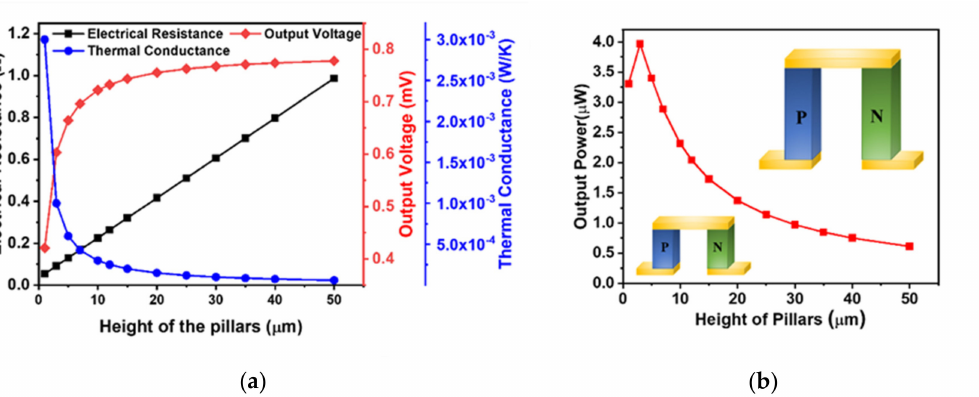
Figure 4. ( a ) Electrical resistance, output voltage and thermal conductance vs. pillars’ height at 5 K temperature gradient; ( b ) power output as a function of pillars’ height at 5 K temperature gradient.